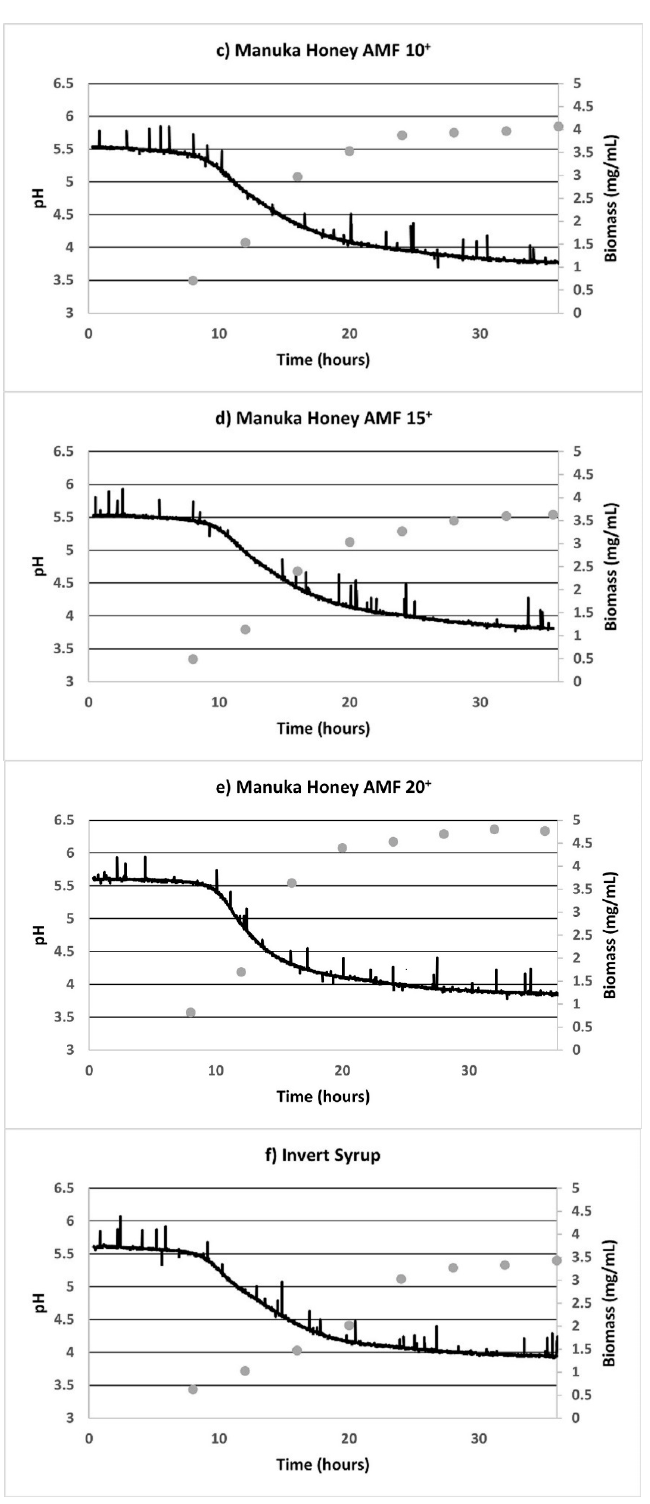
Figure 3. Online pH fermenter curves for L. reuteri DPC16 in fermented MRS broth with ( a ) unsweetened control, ( b – e ) AMF TM 5 + , 10 + , 15 + and 20 + Manuka honey, respectively, and ( f ) invert syrup as the substrate. Average biomass (mg/mL) is shown in the secondary axis ( • ). The spikes in pH values were as seen in the anaerobic fermentation set-ups in our